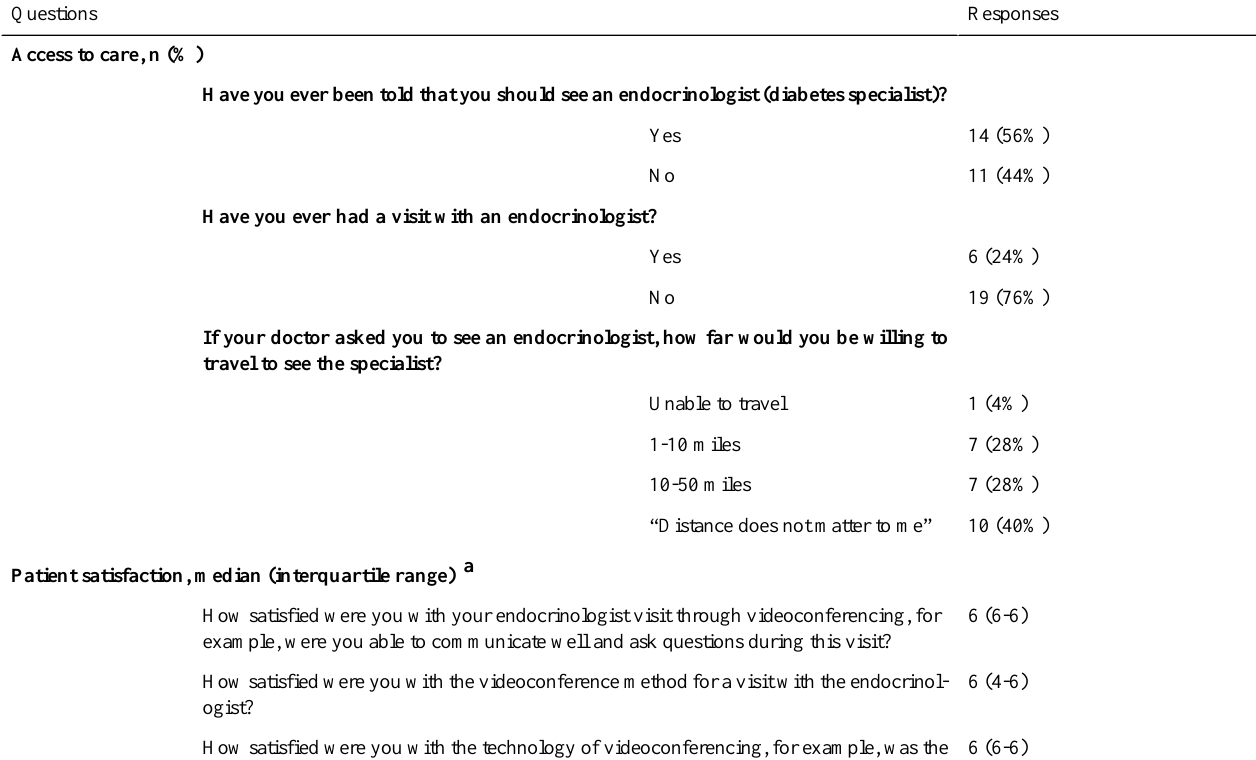
Table 1. Patient and provider satisfaction with diabetes teleconsultations.